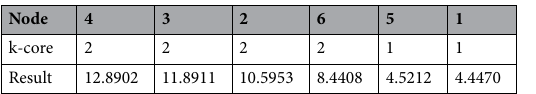
Table 2. Comparison result of simple network node influence evaluation indexes.